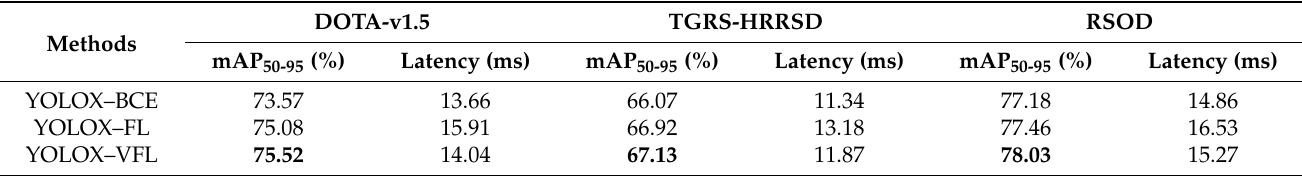
Table 4. Test results of different confidence loss functions.